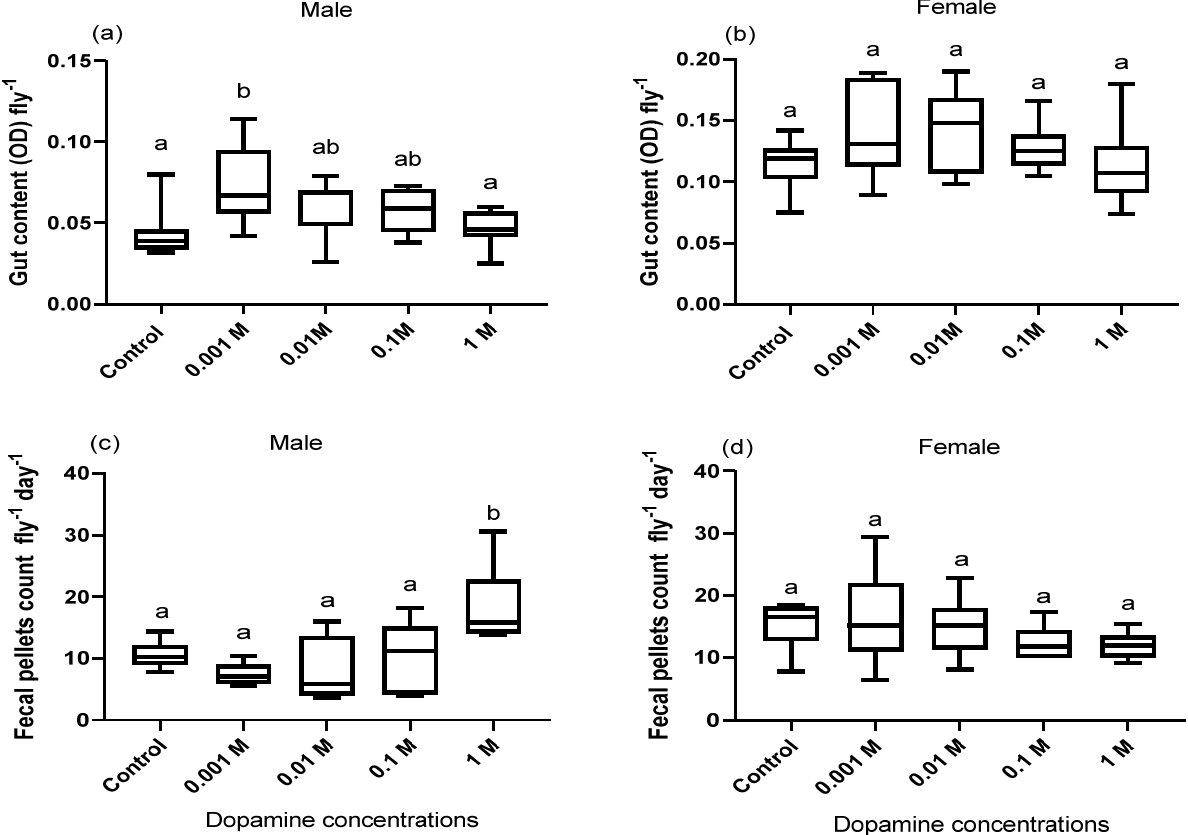
Figure 1. The gut content ( a , b ) and the fecal pellets count ( c , d ) of adult flies ( n = 5) fed on blue food media spiked with different concentrations of dopamine compared to control flies fed standard food media without dopamine. Symbols on the box plot represent the maximum and minimum values (whiskers: ┬ ┴ ) and mean values (-). Different lowercase letters indicate statistically significant dif- ferences between treatments (one-way ANOVA with Tukey’s post hoc test, p < 0.05).